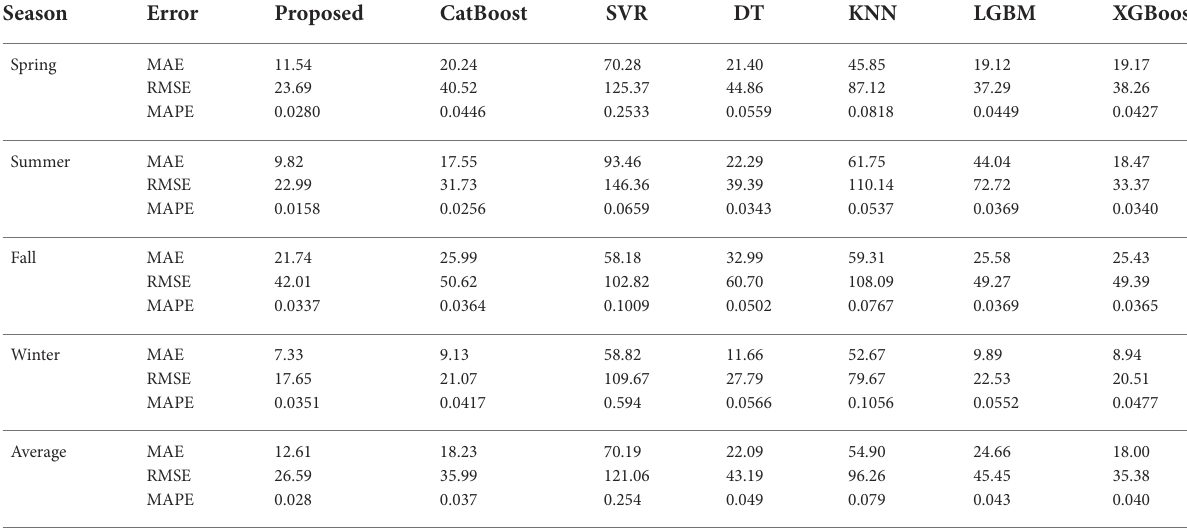
TABLE 2 The seasonal 15-min ahead forecasting results for various contrast models. Season Error